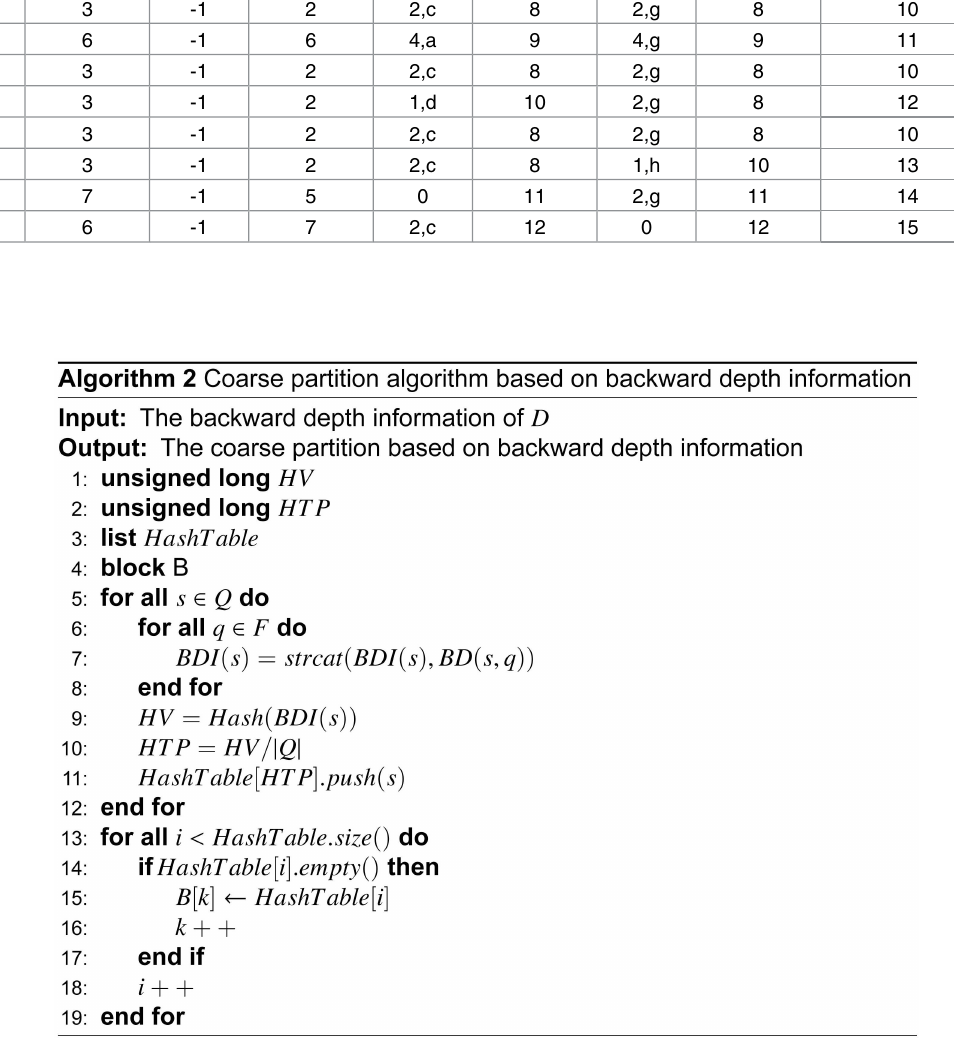
Fig 5. Coarse partition algorithm based on backward depth